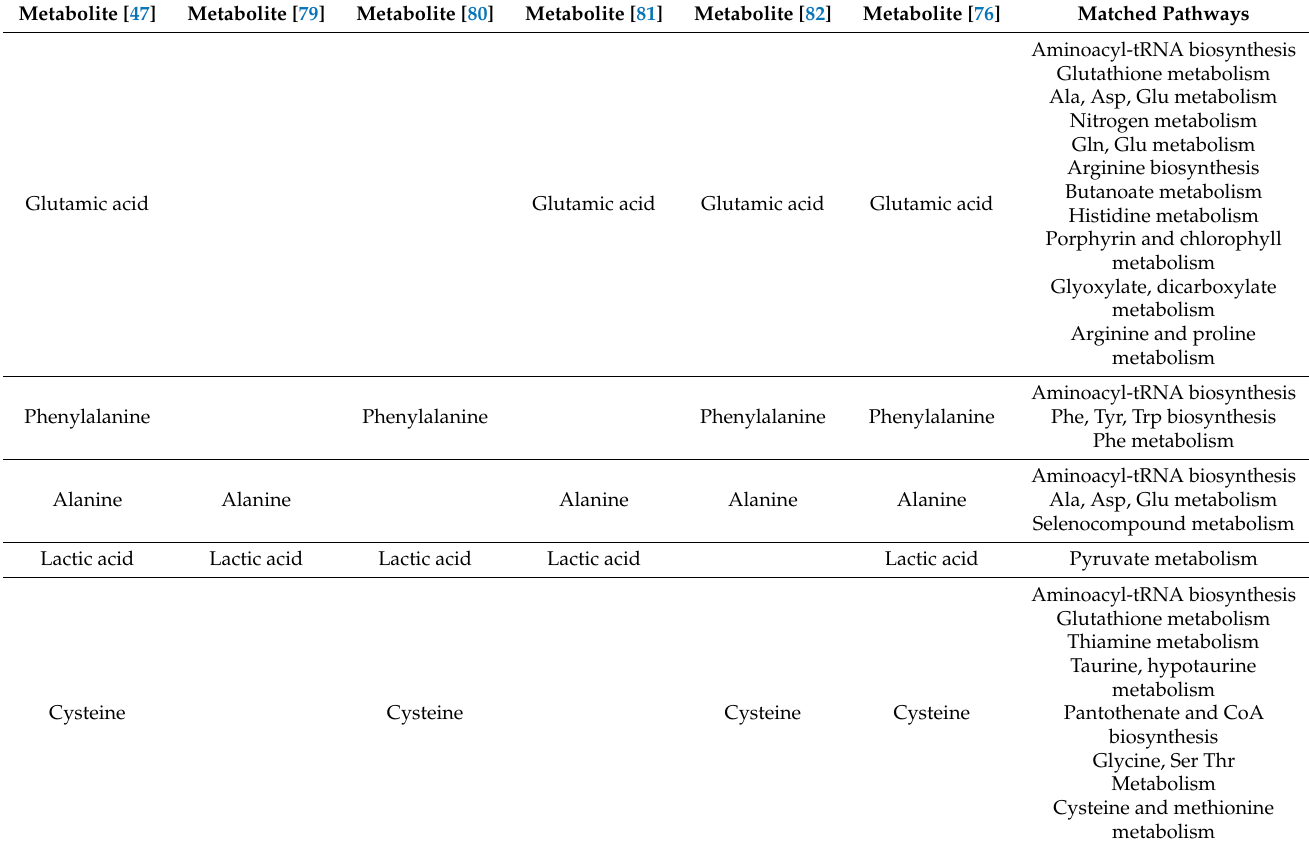
Table 8. Metabolites reported by at least four out of six studies listed in Table S2 and their associated metabolic pathways. Metabolite